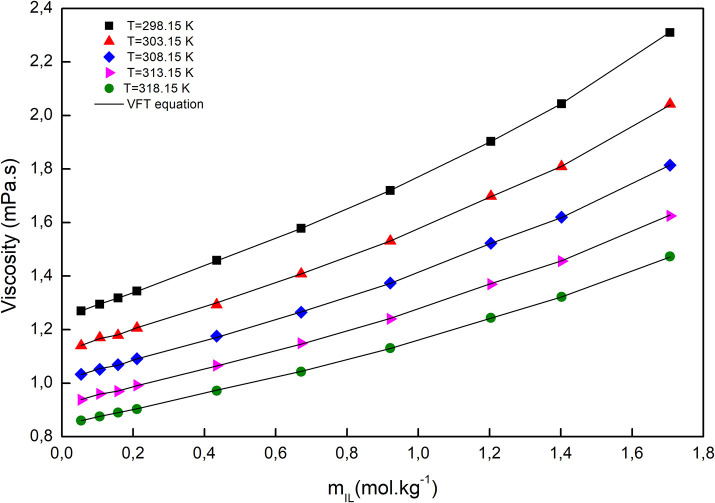
The viscosity of [C2mim]Cl + H2O + K3PO4 as a function of [C2mim]Cl molality at different temperatures.